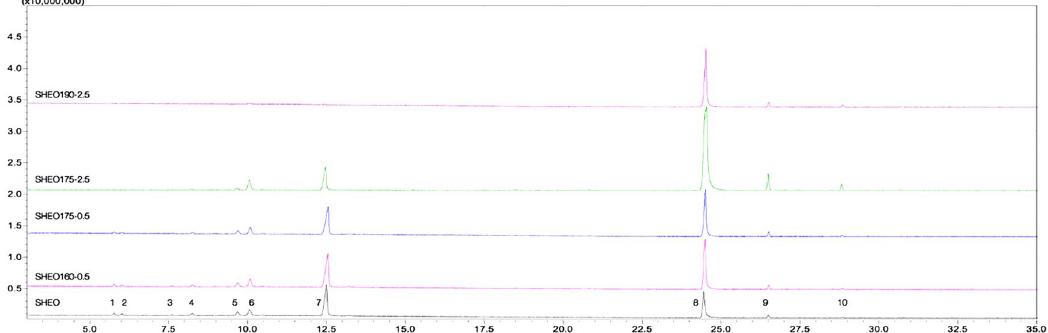
Figure 1. Chemical composition of Satureja hortensis essential oil. Unheated and heated essential oils chromatograms (1-α-thujene, 2-α-pinene, 3-sabinene, 4-β-pinene, 5-α-terpinolene, 6- p -cymene, 7-γ-terpinene, 8-carvacrol, 9-caryophyllene, 10-β-bisabolene) obtained by GC–MS. Annotations. Satureja hortensis essential oil denoted as SHEO and heated essential oils at different temperatures and periods denoted as SHEOx-y, where x is the temperature of treatment (ºC), and y is the heating time in hours (SHEO160-0.5, SHEO175-0.5, SHEO175-2.5, and